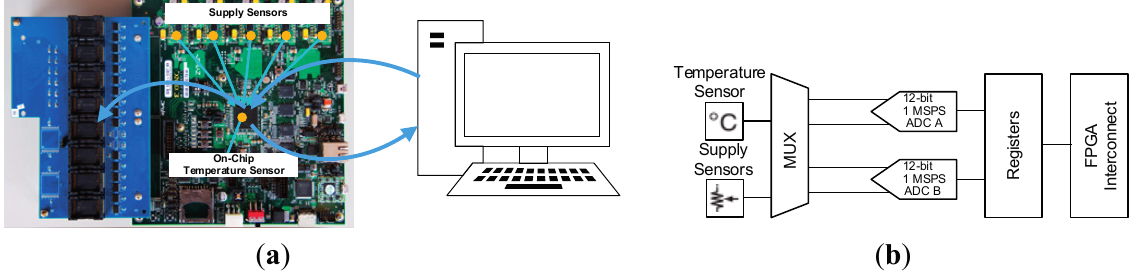
Figure 10. ( a ) The system architecture and illustration of the data flow ( b ) Zynq on-board sensor system block diagram.